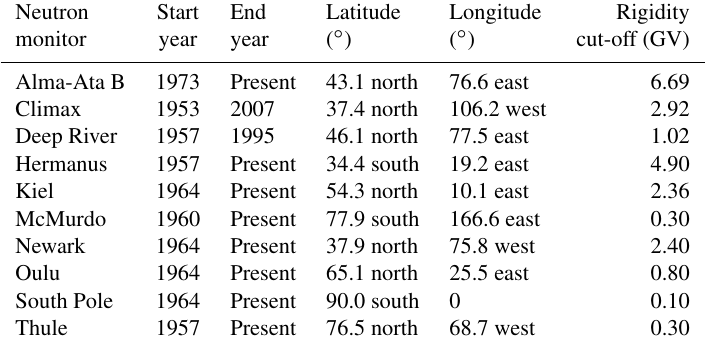
Table 1. Neutron monitors used in the study with their dates of use, latitudes, longitudes and cut-off rigidities. Note that South Pole does not have a particular latitude due to its polar location. Table collated from data collected using the neutron monitor database at http:// www.nmdb.eu apart from Climax and Deep River from http://cr0.izmiran.ru/common/links.htm and Hermanus from http://www.nwu.ac.za/ neutron-monitor-data. Note that Alma-Ata B, Climax and South Pole are all located at high altitudes. Neutron Start End Latitude Longitude Rigidity monitor year year cut-off (GV) Alma-Ata